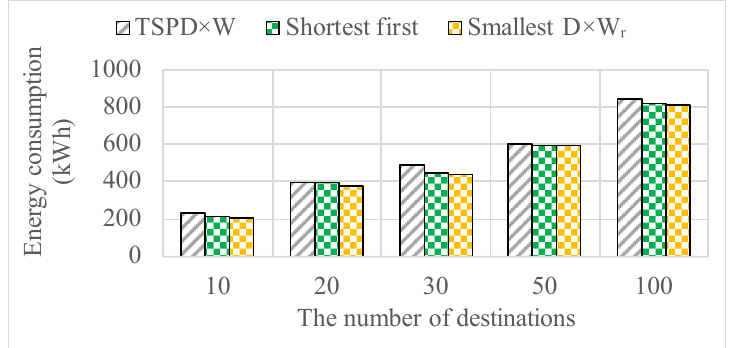
Figure 9. Greedy and approximate TSP algorithms on large problem instances.